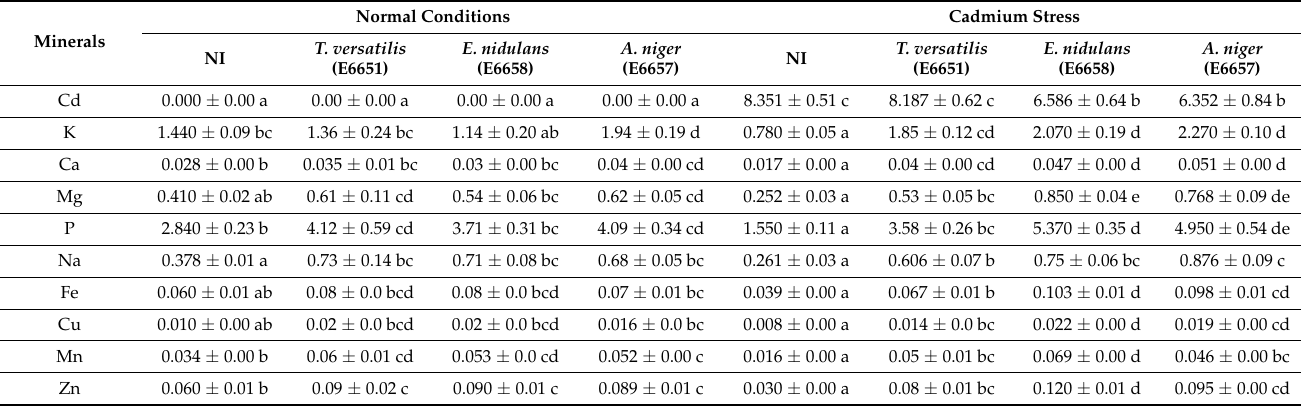
Table 1. Mineral content in leaves of geranium non-inoculated (NI) or inoculated with different endophytic fungi under normal conditions and Cd-stress; after 17 days of applying stress. Normal Minerals